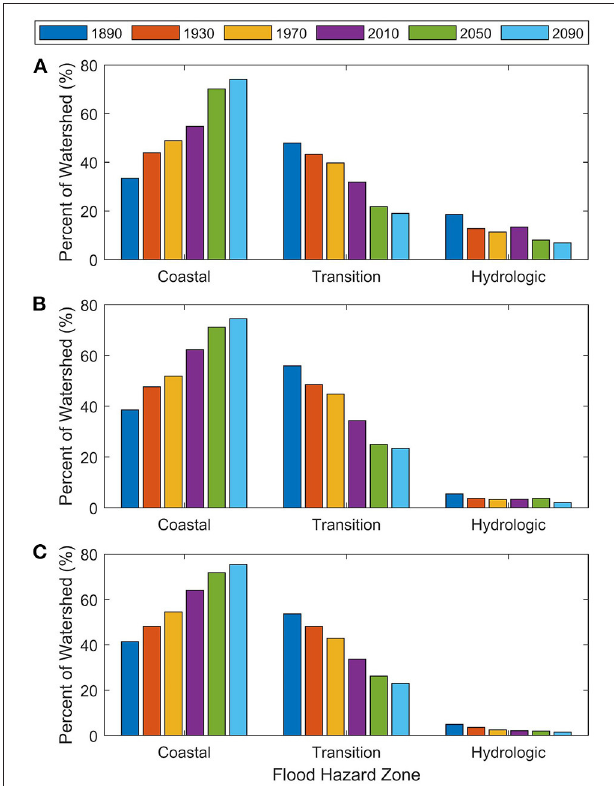
FIGURE 5 | Percent of the watershed made up of each flood hazard zone for the Barataria watershed under different flood magnitudes: (A) low, (B) medium, and (C) high flood events. Each bar color represents a different era